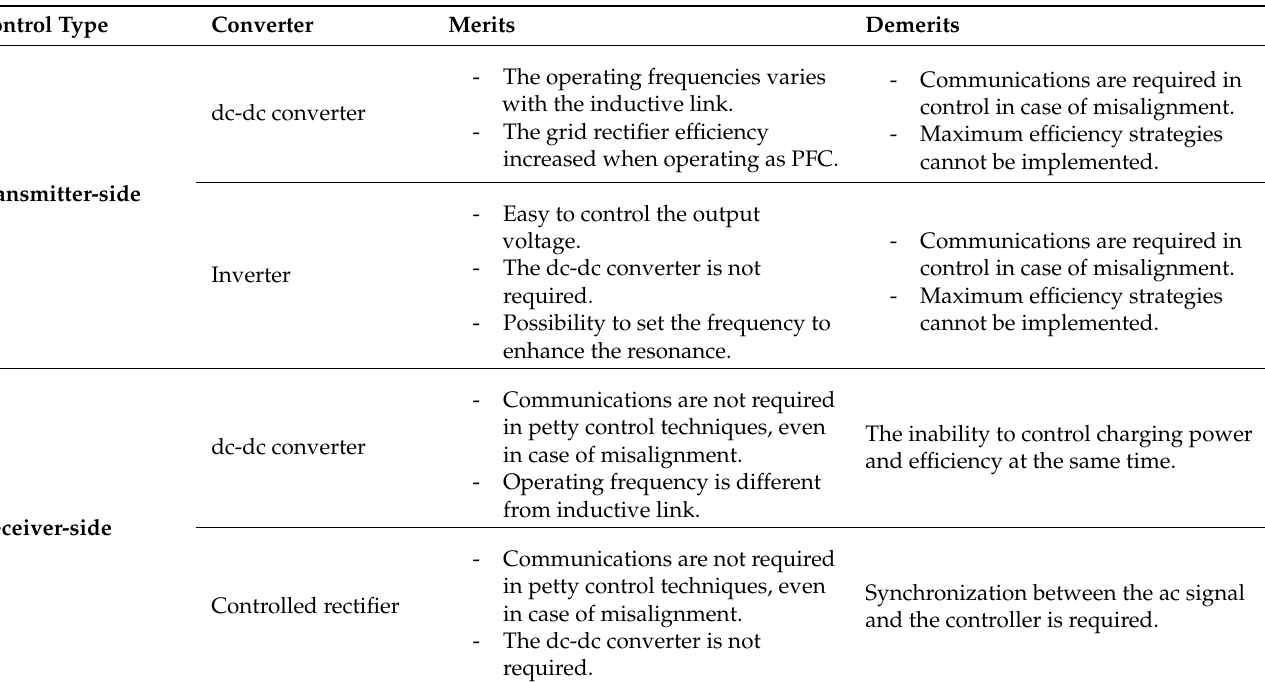
Table 14. Comparison between merits and demerits of each control